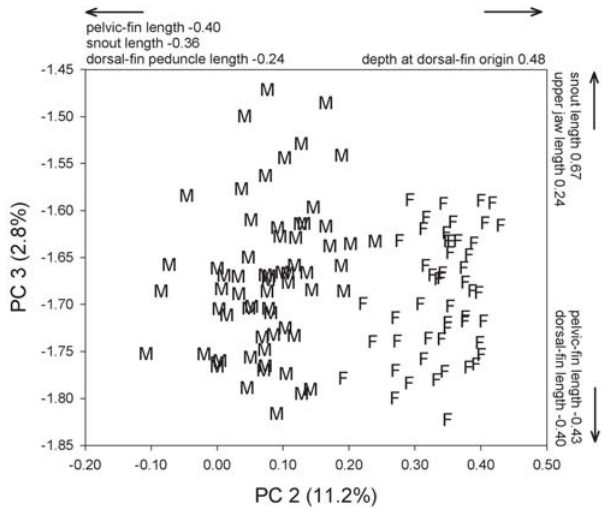
Fig. 5. Principal component analysis of the 18 morphometric data of males (M) and females (F) of Odontostilbe fugitiva . Stronger loadings on the second and third principal compo- nents (PC2,